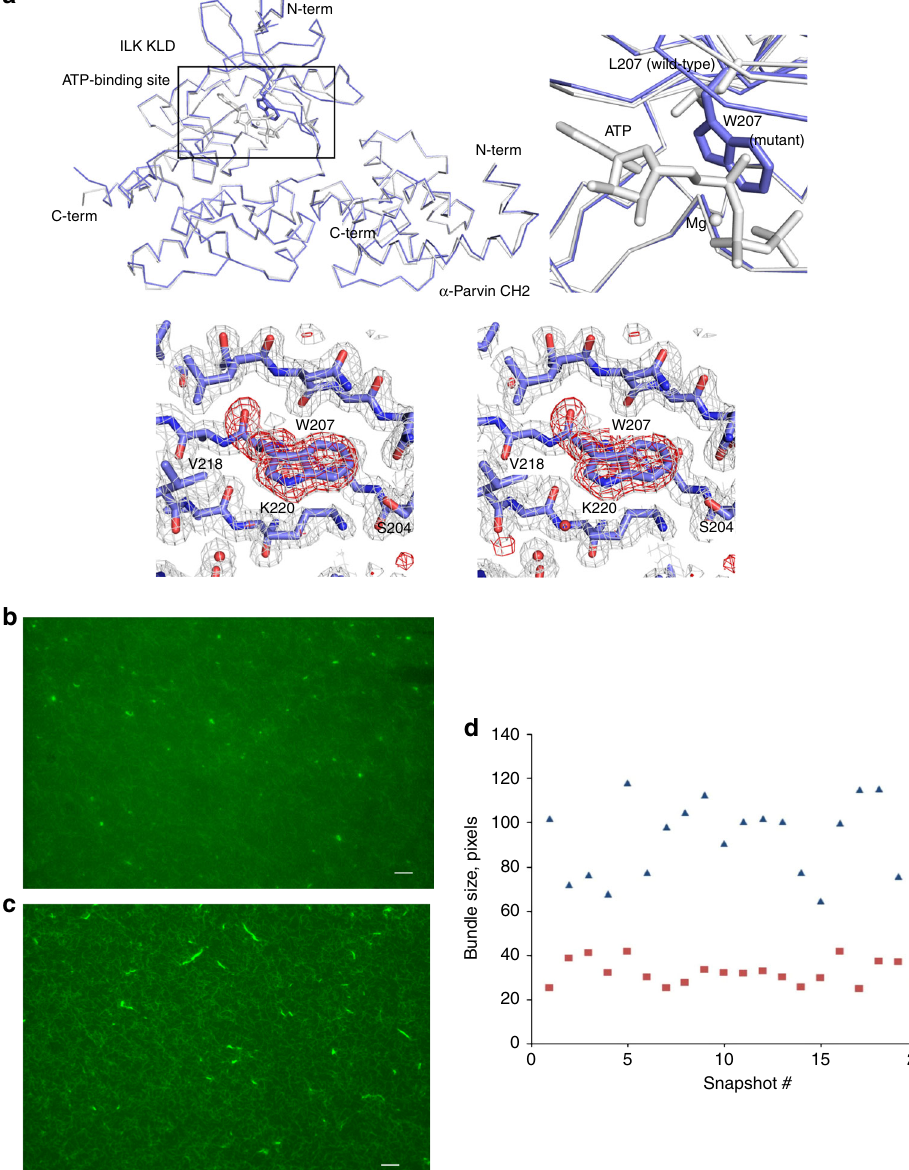
Fig. 6 ILK L207W mutation disrupts the F-actin bundling. a (Top left) Structural comparison of the ILK KLD bound to α -Parvin CH2 and (colored in gray; PDB ID 3KMW) and its comparison with the ILK mutant form (colored in blue). The superposition of the mutant ILK KLD (267 aligned C α atoms) to the ATP-bound (PDB ID 3KMW) and -free (PDB ID 3KMU) forms shows overall similarities with root-mean-square deviations of 0.58 Å and 0.47Å, respectively. A small conformational change is observed in the ATP-binding site of the mutant ILK KLD likely due to mutation or distinct crystal packing. (Top right) Close-up view of the ATP-binding sites of the ILK KLD between ATP-bound wild type (gray) and de fi cient mutant (blue). Mg, ATP, L207 in the wild type, and W207 in the mutant ILK KLDs are highlighted in ball and stick models. (Bottom) Close-up stereo view of the loss-of-ATP-binding mutation site in the ILK KLD. The 2Fo-Fc electron density map contoured at 1 σ is shown in gray mesh. The Fo – Fc omit map calculated from the mutant structure without the residue (W207), contoured at 3.5 σ , is overlaid (red mesh). Selected residues in the ATP-binding site are labeled. b Representative microscopic image showing that IPP L207W impaired F-actin bundle formation (no larger bundles) as compared with the WT IPP in ( c ). Selected microscopic image showing F-actin bundles in the presence of WT IPP. Bar = 100 μ m. d Quantitative comparison of the F-actin bundle sizes of the randomly selected 20 slides showing the mutation dramatically reduced the F-actin bundle sizes (red squares) as compared with those induced by WT IPP (blue chromatography column followed by HiLoad 16/60 Superdex 200 gel fi ltration and PINCH-1 (residues 1 – 325), and human α -Parvin (residues 1 – 372) were PCR- HiTrap SP cation-exchange chromatography columns (all from GE Healthcare). ampli fi ed and subcloned into a polycistronic coexpression vector pST39 41 The mutant proteins (IPP L207W, IPP-4A, and IPP-4A5A) of the IPP complex according to the inventor ’ s protocol. Two surface cysteine residues of ILK were were generated by QuikChange Site-Directed Mutagenesis kit (Agilent), and were substituted by serine residues (C346S; C422S) to improve the protein solubility of expressed and puri fi ed as for the IPP-WT. For GST-fused various fragments of ILK, as previously demonstrated 13 , and designated as the IPP-WT. The tricistronic human α -Parvin, each gene of the N-terminal domain (residues 1 – 89), or its coexpression construct contains a hexahistidine-tag sequence followed by a mutant 5A (1 – 91) or the full-length (residues 1 – 372) of α -Parvin was subcloned thrombin cleavage site prior to the sequence of PINCH-1 for conventional af fi nity into pGEX4T1 vector (GE Healthcare). These GST-fused α -Parvin proteins were puri fi cation. The hexahistidine-tagged IPP complex was coexpressed in E. coli BL21 expressed in E. coli and af fi nity-puri fi ed by glutathione-Sepharose 4B af fi nity (DE3) pLysS and puri fi ed from the bacterial cell lysate by Ni-af fi nity